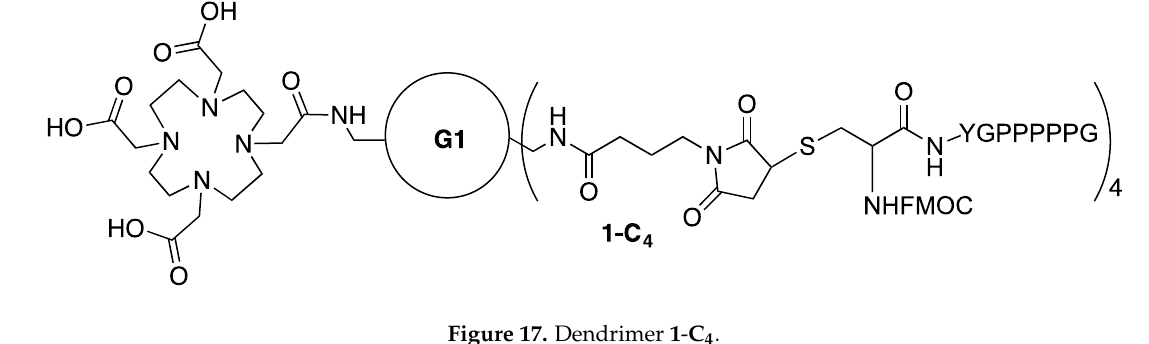
Figure 15. Dendrimer 1 - C 4 . Figure 17. Dendrimer 1 - C 4